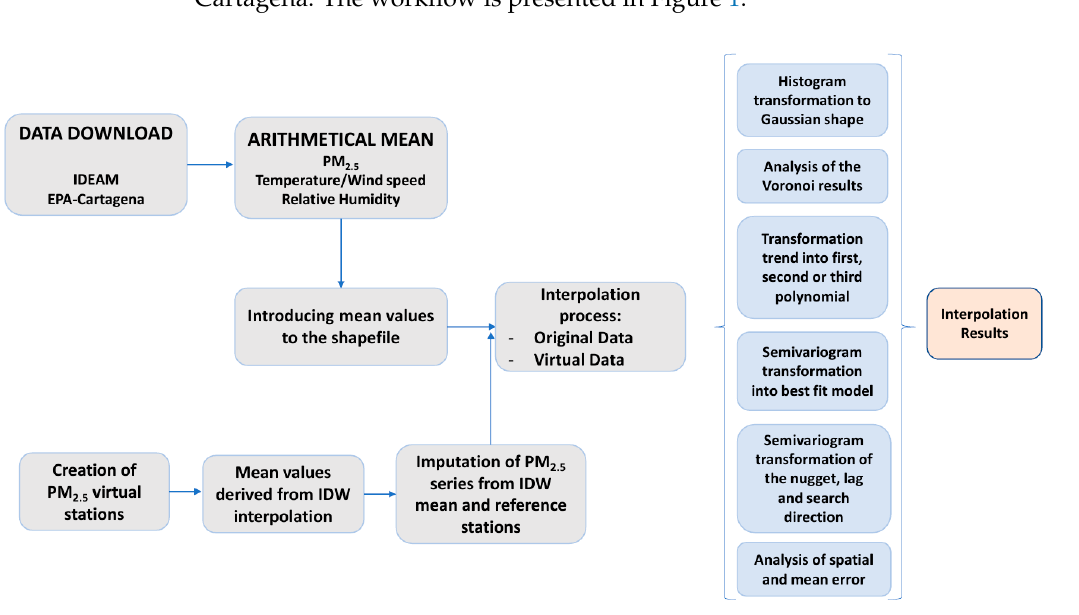
Figure 1. Workflow of the present study.